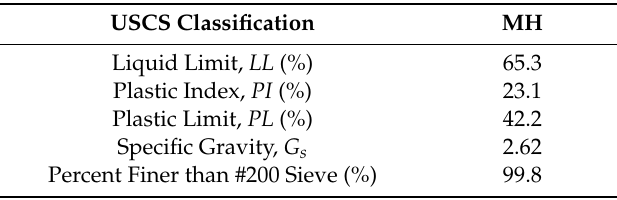
Table 1. Index properties of EPK kaolinite used in this